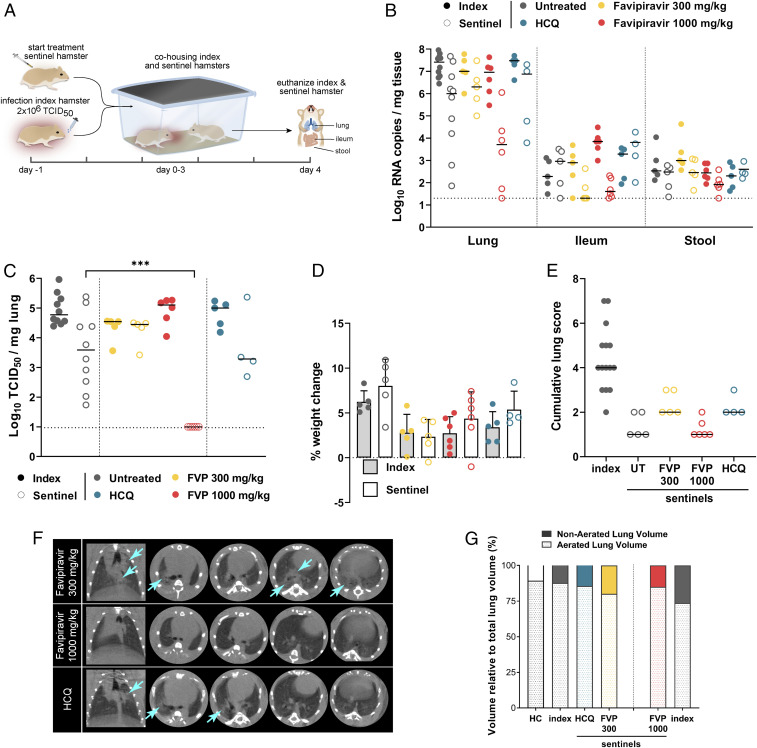
High dose of favipiravir reduces infection in a direct contact transmission model. (A) Setup of the study. (B) Viral RNA levels in the lungs, ileum, and stool at day 4 pi are expressed as log10 RNA copies per milligram of tissue. Closed dots represent data from index hamsters (n = 5) inoculated with SARS-CoV-2 1 d before cohousing with sentinel animals. Open dots represent data from sentinel hamsters (n = 5 per condition) which were untreated (gray) or treated with either HCQ (blue) or favipiravir 300 mg/kg (yellow), 600 mg/kg (orange), or 1,000 mg/kg (red), starting 1 d before exposure to index animals. The bars represent median values. (C) Infectious viral loads in the lung at day 4 pi/postexposure are expressed as log10 TCID50 per milligram of lung tissue. The bars represent median values. (D) Weight change at day 4 pi in percentage, normalized to the body weight at the day of infection (index) or exposure (sentinel). Bars represent means ± SD. (E) Cumulative severity score from H&E stained slides of lungs from index SARS-CoV-2−infected hamsters and untreated, favipiravir, and HCQ treated sentinel hamsters. The bars represent median values. (F) Representative coronal and transversal lung micro-CT images of favipiravir and HCQ treated sentinel hamsters at day 4 pi. Light blue arrows indicate examples of pulmonary infiltrates seen as consolidation of lung parenchyma. (G) Micro-CT−derived nonaerated lung volume (reflecting the tissue lesion volume) and aerated lung volume relative to total lung volume of index SARS-CoV-2−infected hamsters and untreated, favipiravir (FVP), and HCQ treated sentinel hamsters. HC, healthy controls. Data were analyzed with the Mann−Whitney U test. ***P < 0.001.